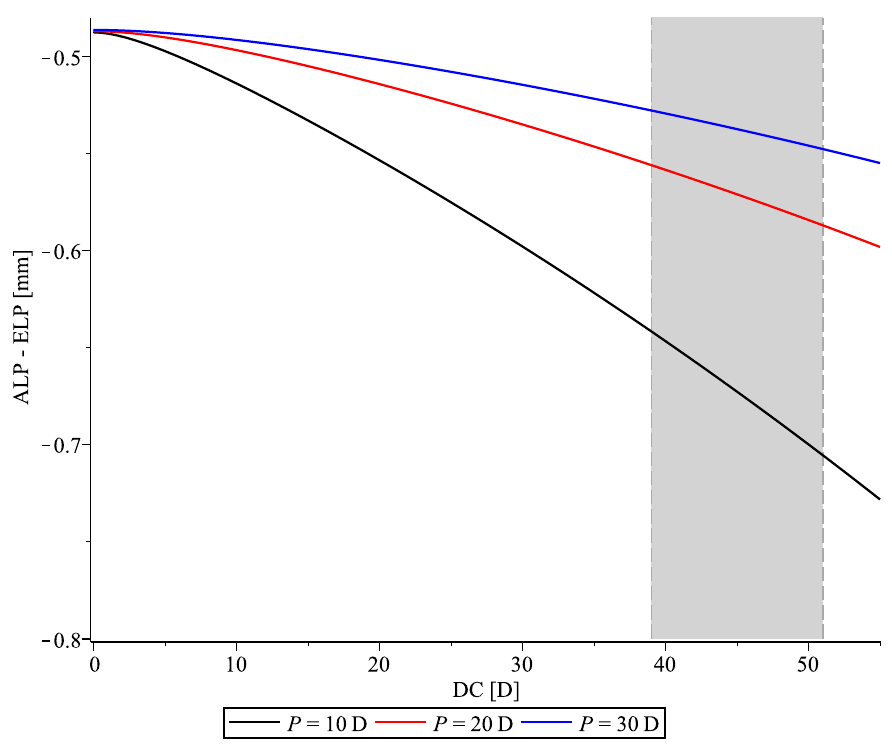
Fig 4. The difference between the anterior intraocular lens (IOL) vertex and the effective lens position of the thin lens equivalent as a function of corneal power (DC) for IOLs with optical power P = 10 D, 20 D, 30 D. The clinically relevant range of corneal power is marked in